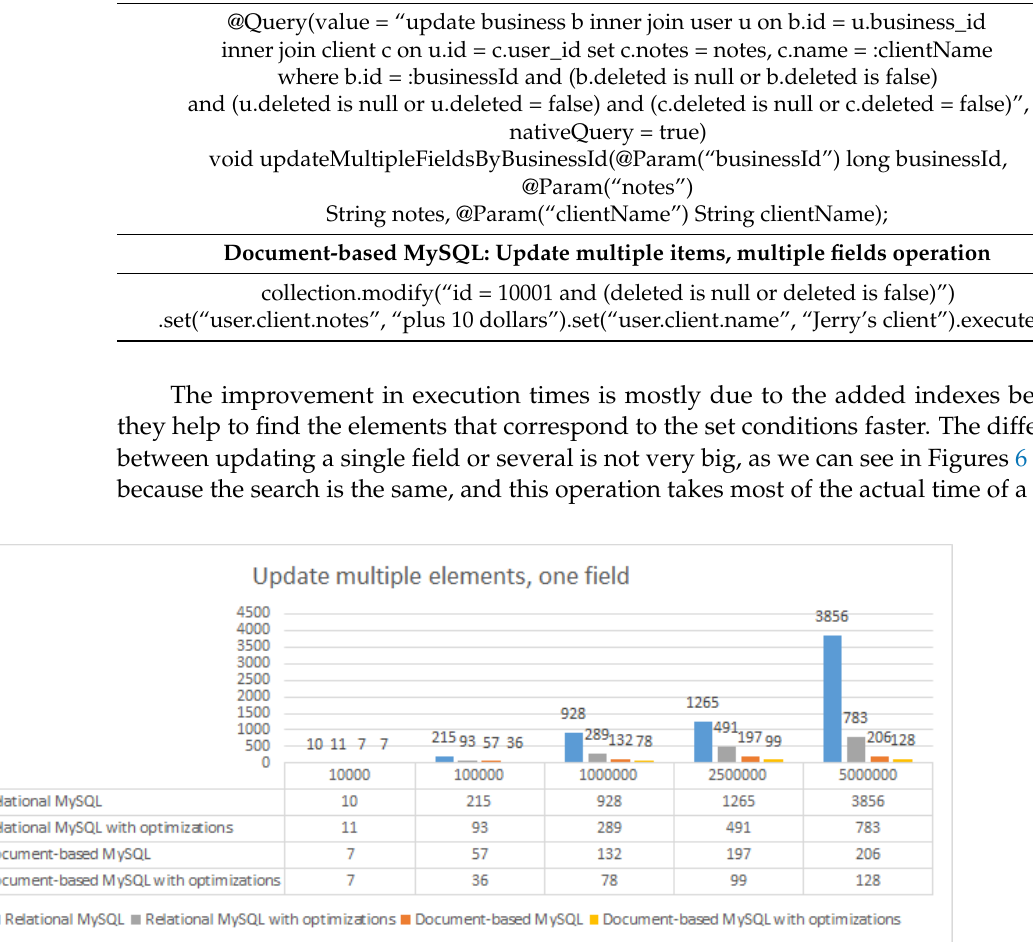
Figure 6. Performance time (ms) for the update multiple elements and one field operation.